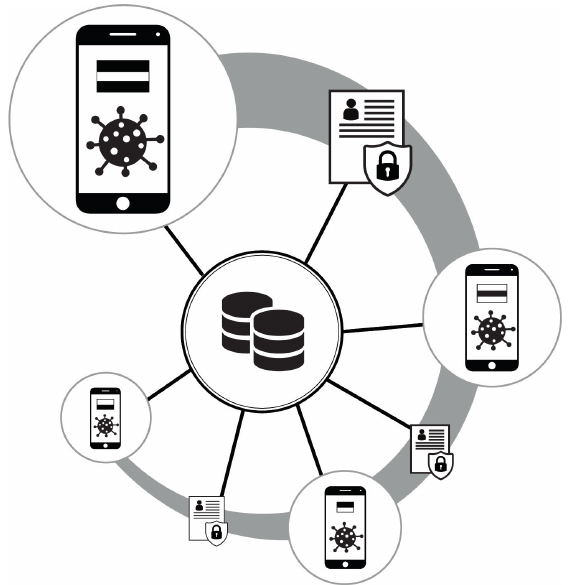
Figure 1. Data collection and processing by COVID-19 apps leading to a common and centralised database for tracking the spread of